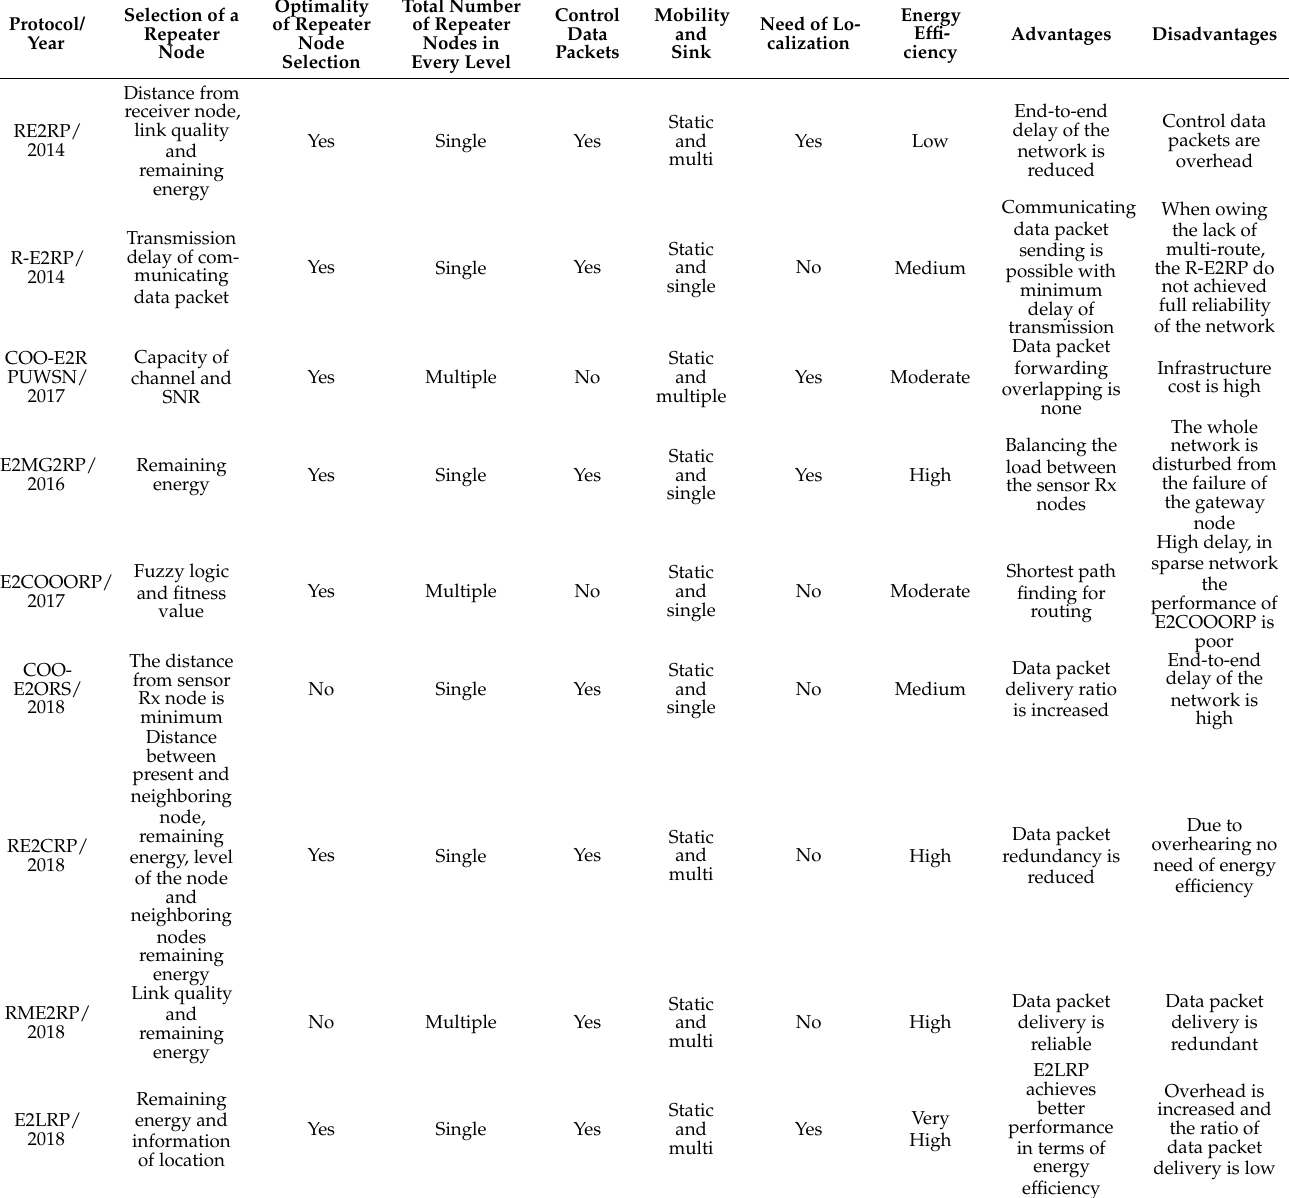
Table 10. Comparison of the basic characteristics of